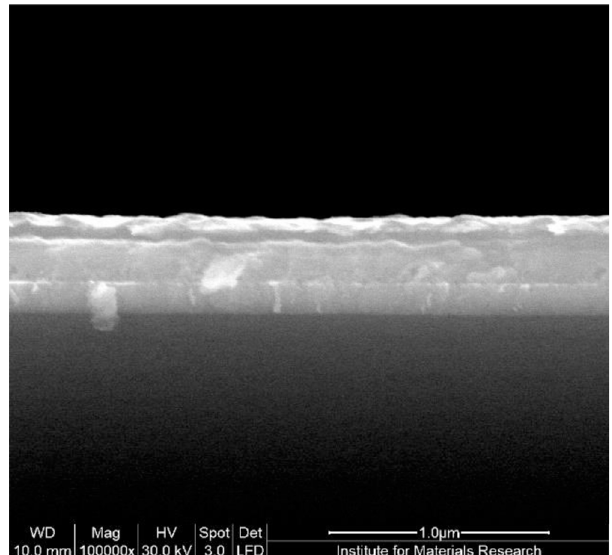
Fig. 11. Cross section of a perovskite solar cell fabricated by USSC and high pressure gas quenching, with 0.5 M solution.